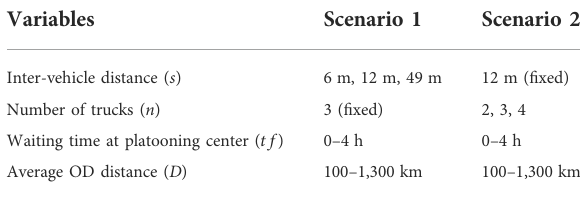
TABLE 3 Scenarios examined.